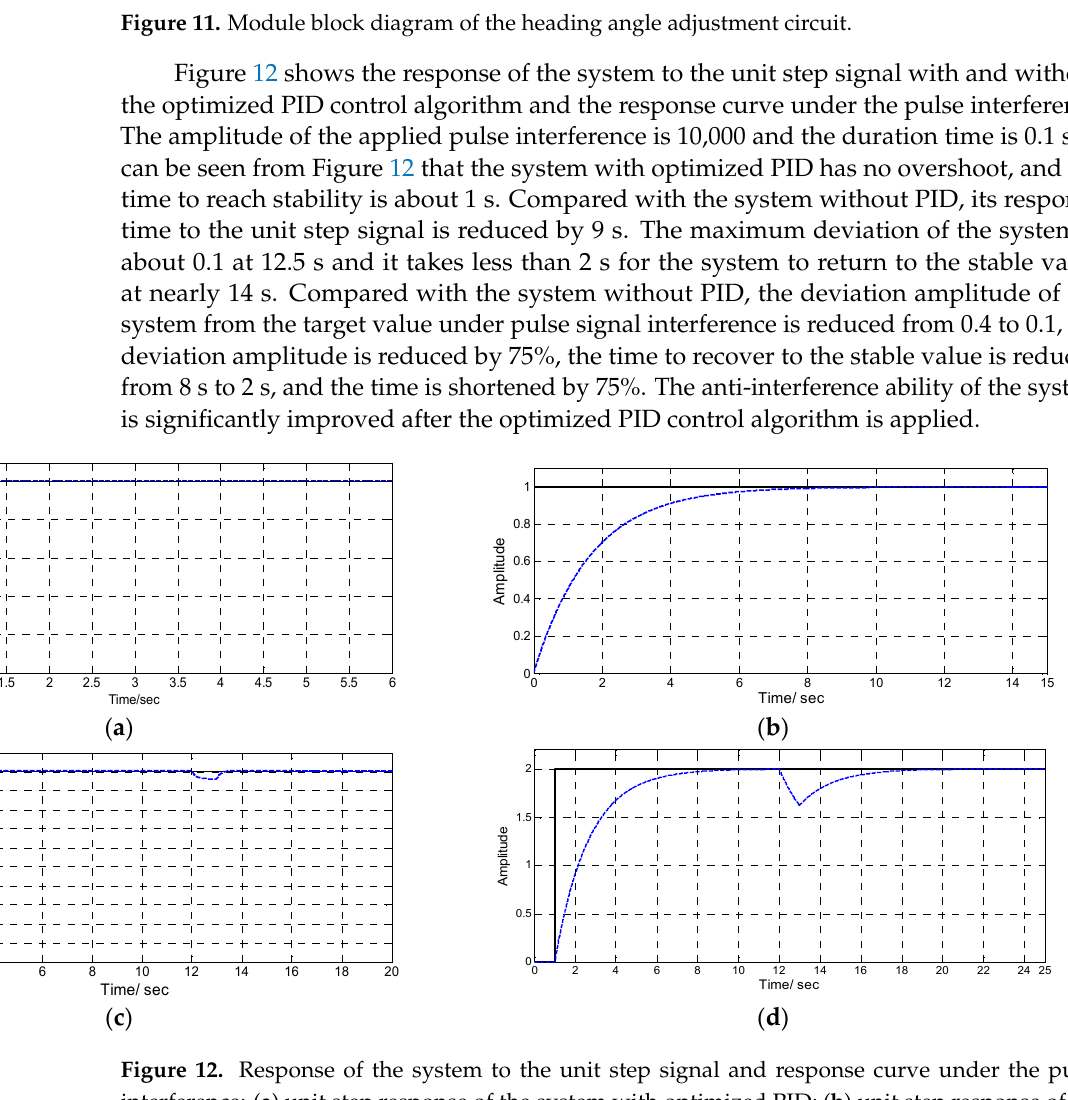
interference: ( a ) unit step response of the system with optimized PID; ( b ) unit step response of the